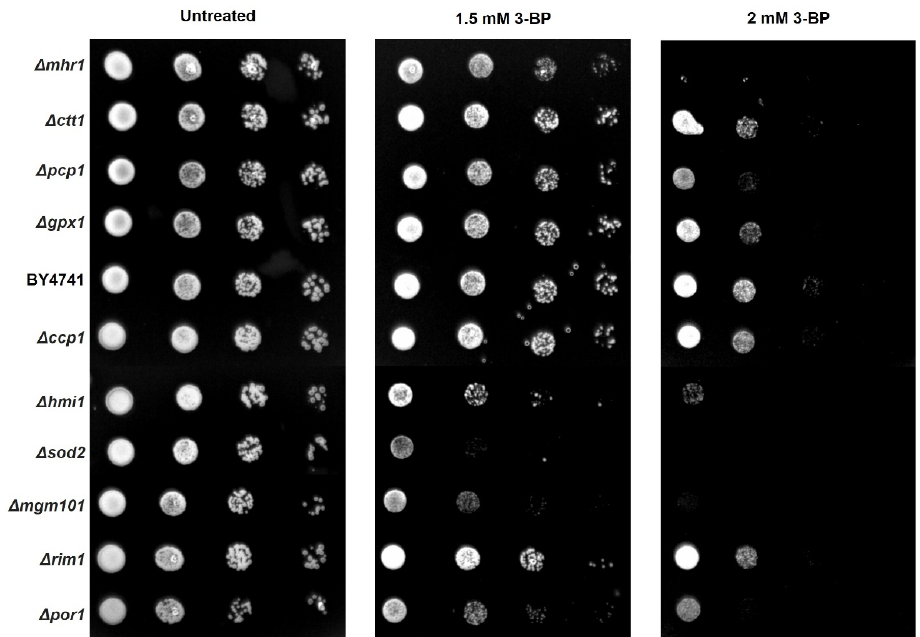
Figure 7. Deletion mutants strains of mtDNA maintenance, repair, and ROS protection genes exhibit increased sensitivity to 3 ‐ BP. Serial dilutions of strains were spotted on SD medium plates with different 3 ‐ BP concentrations and incubated for 2 days at 30 °C.